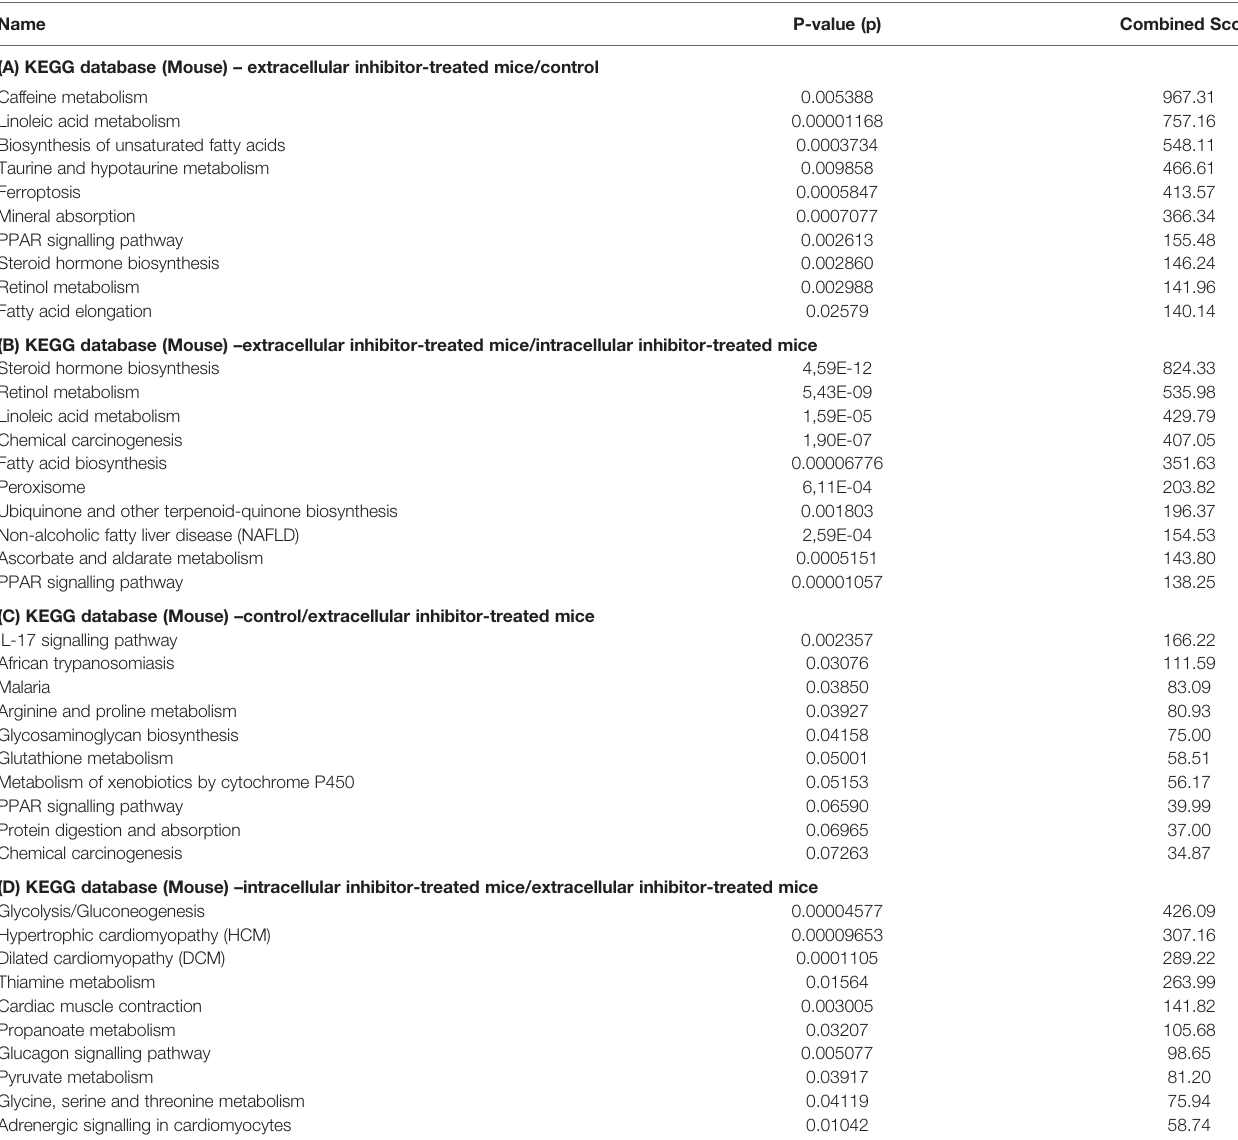
TABLE 1 | Differentially regulated proteins were imported to EnirchR tool and KEGG database was used for pathway enrichment analysis.